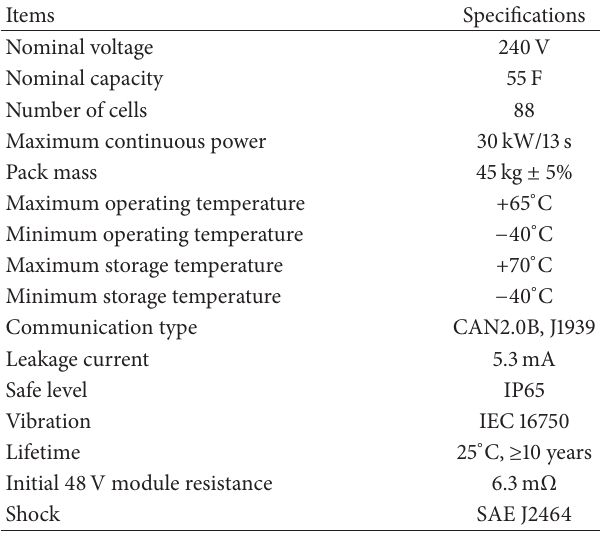
Table 1: Parameters of the supercapacitor